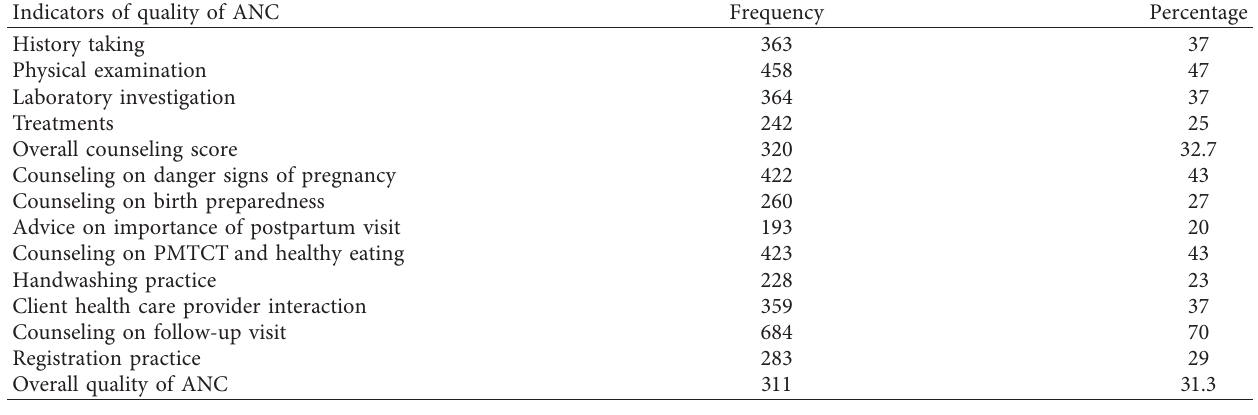
Counseling on PMTCT and healthy eating